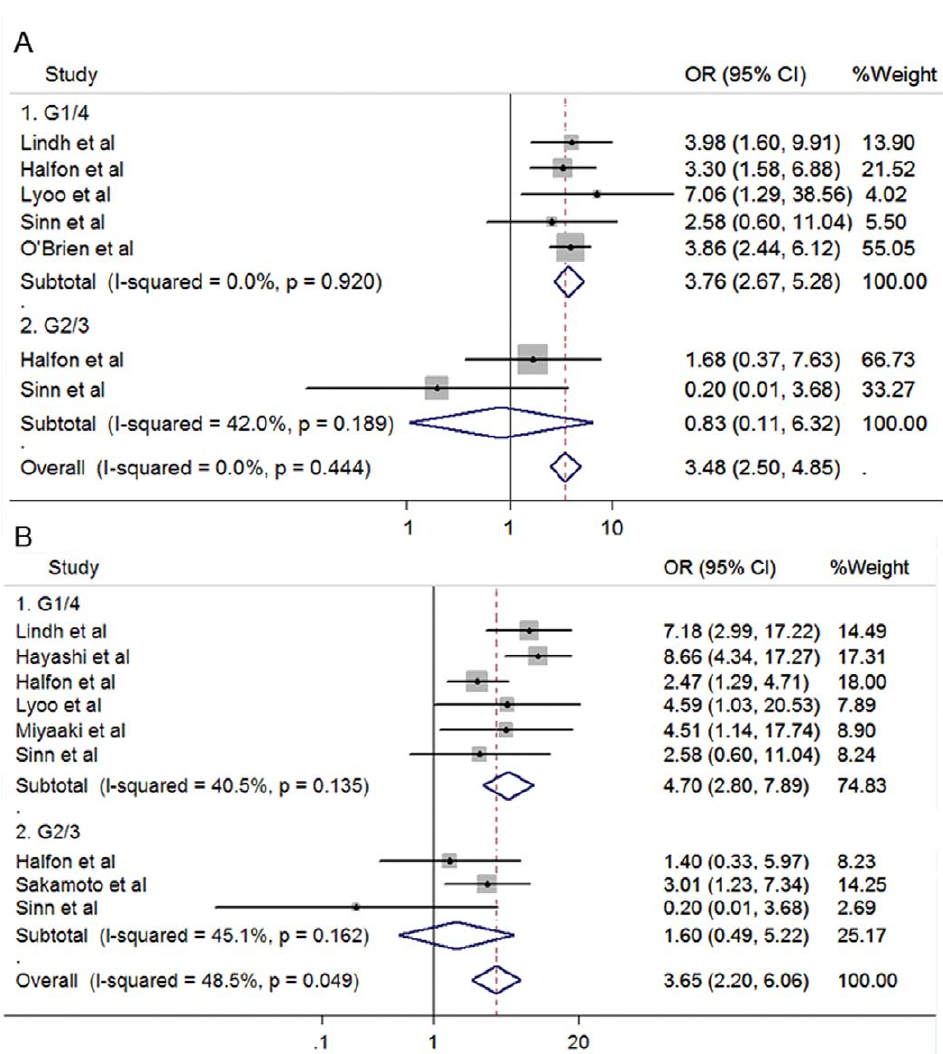
Figure 4. Forrest plots for association between polymorphisms and response to PegIFN/RBV in patients possibly with treatment history. A. rs12979860 (CC vs CT/TT). B. rs8099917 (TT vs TG/GG).